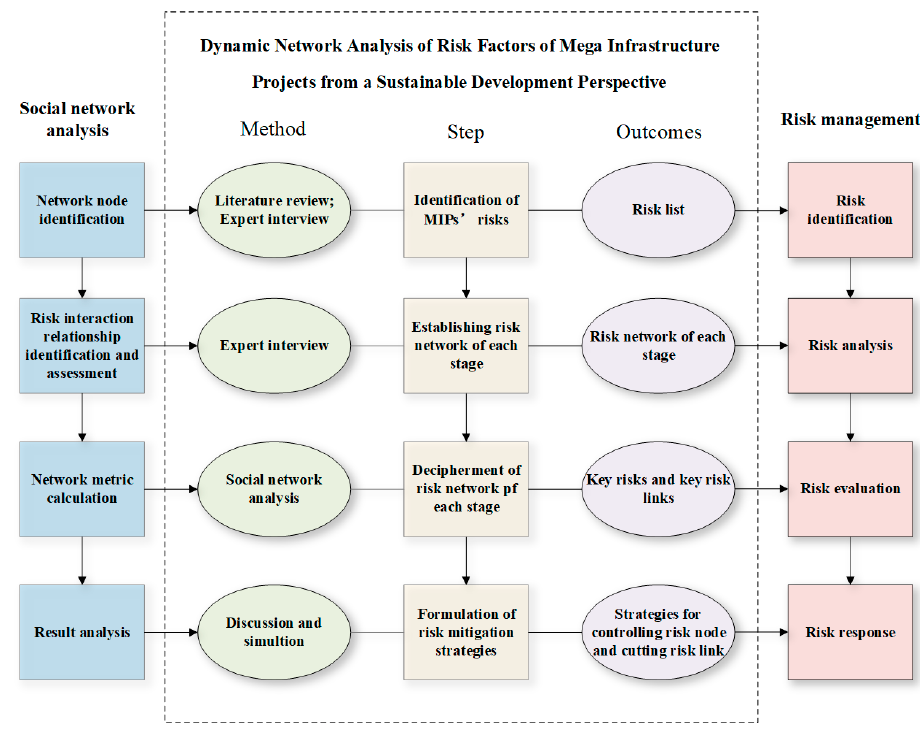
Figure 1. Main research framework.